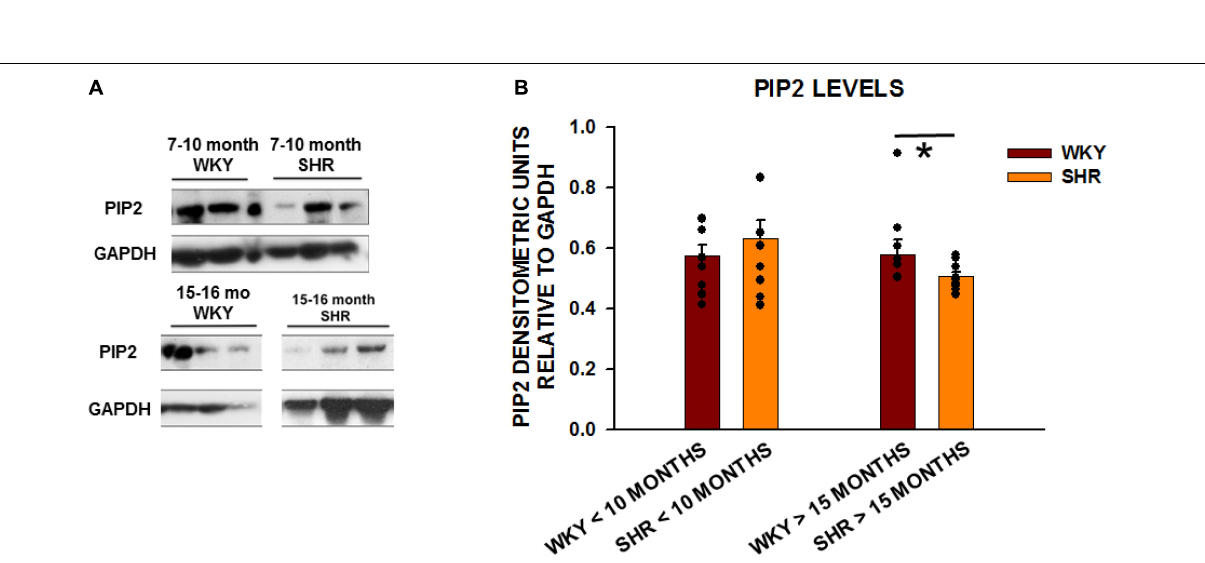
Frontiers in Physiology | www.frontiersin.org